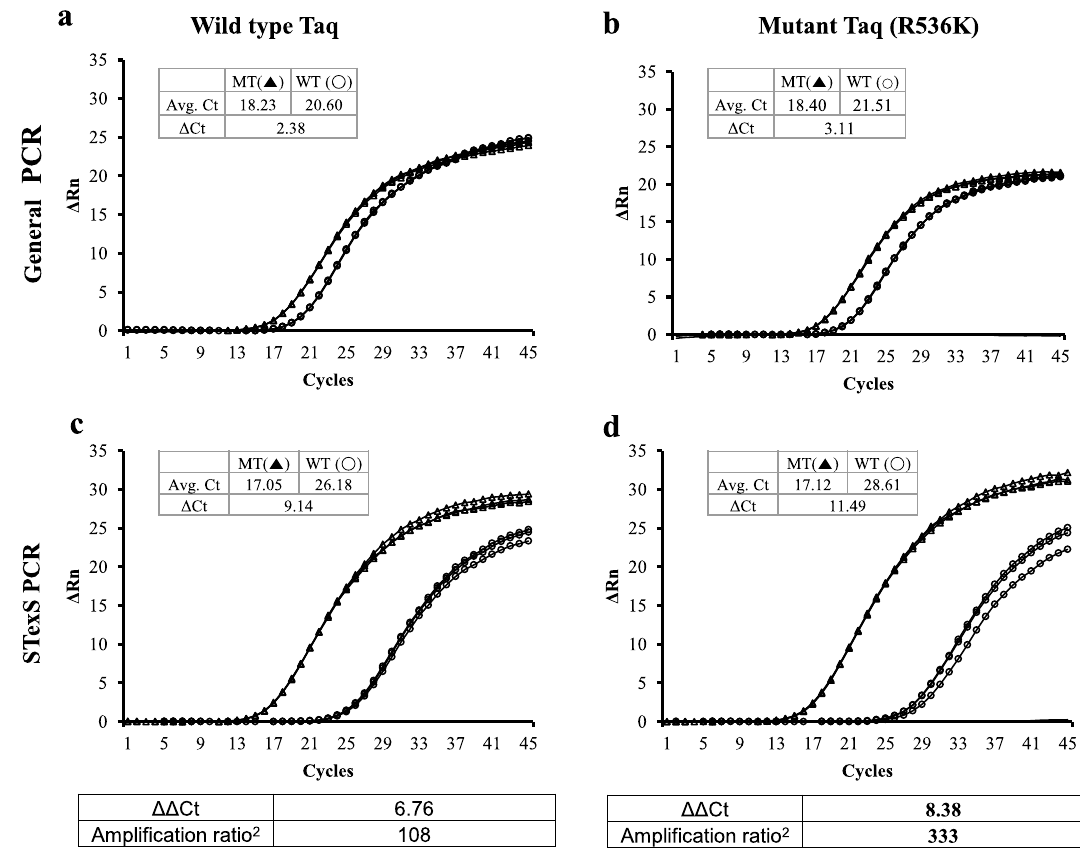
Figure 4. Efficiency of STexS PCR with additional modified DNA polymerase. Each qPCR trial was performed using wild type Taq and mutant Taq (R536K). Each amplification ratio is quantified by ΔΔCt of wild type ( a , c ) and mutant ( b , d ) Taq. qPCRs were performed with 790-F58-1 for EGFR T790M, and 4 uM of AHP3 as dbOligo for STexS PCR was used. The amplification ratio 2 was calculated by using the ΔΔCt values of each wild type Taq and mutant Taq to compare between general ( a , b ) and STexS ( c , d ) PCR.